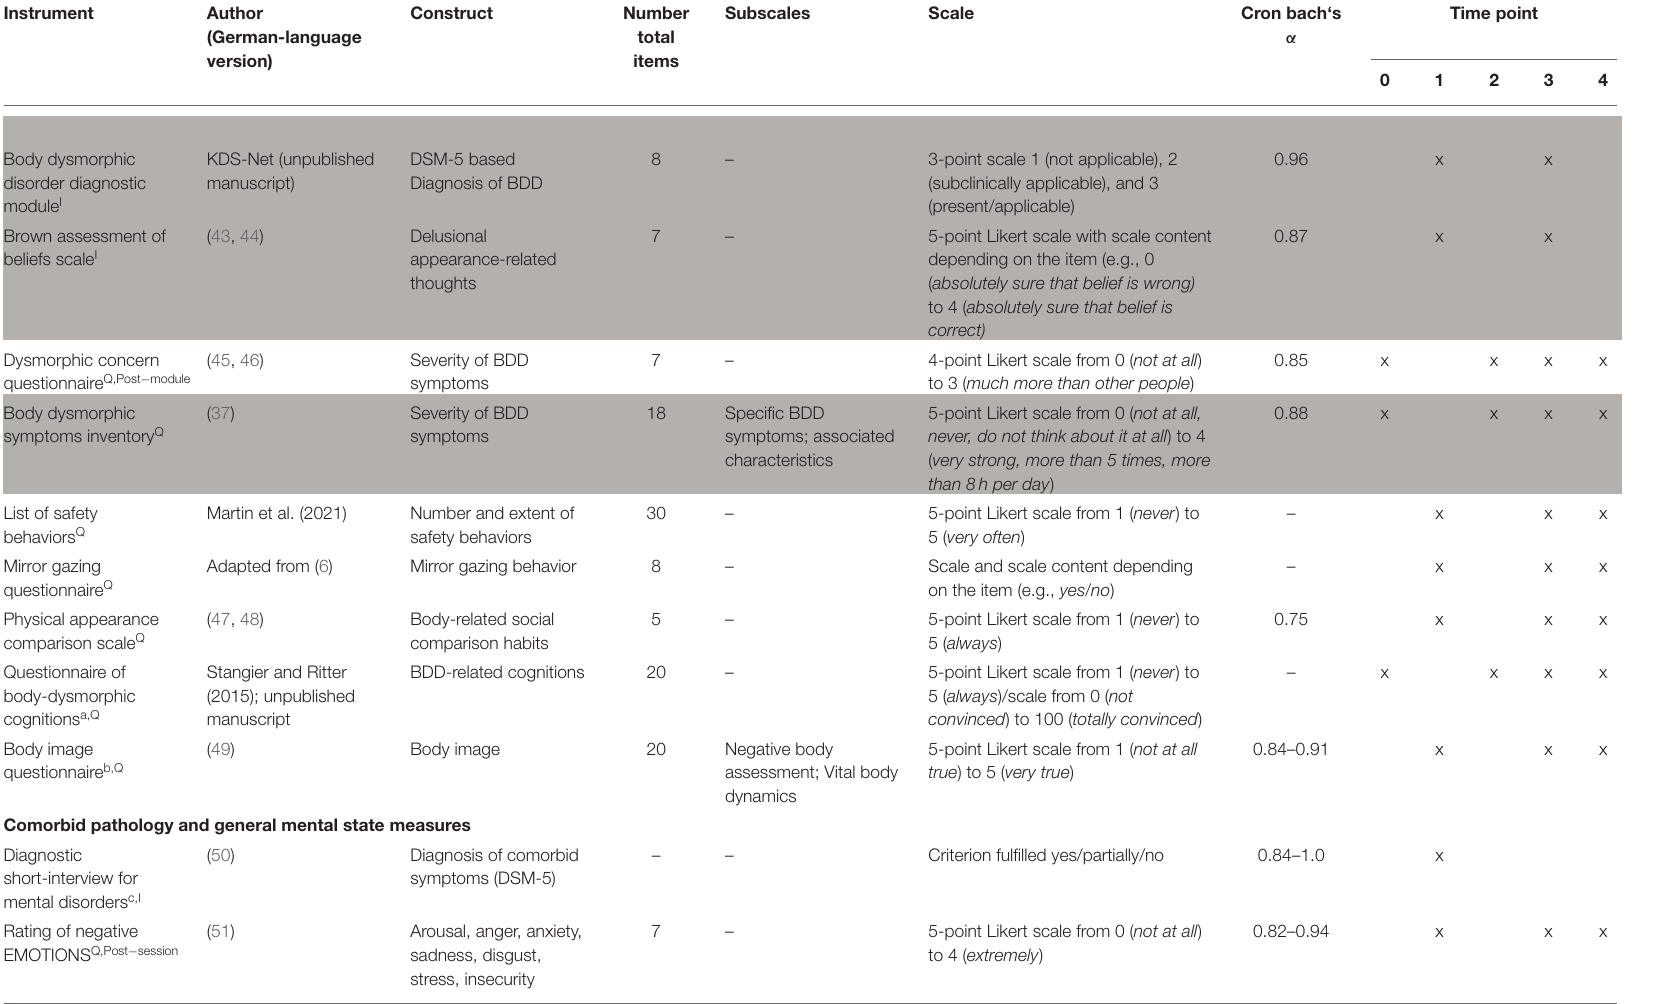
TABLE 2 | Description of instruments and psychometric characteristics as well as points of